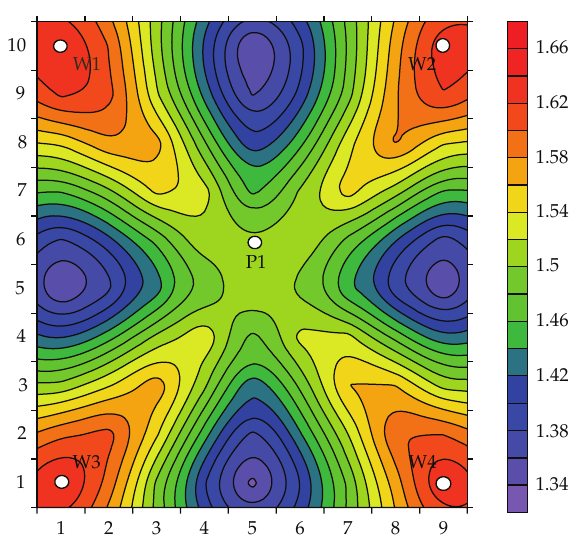
Figure 1: Permeability (cid:2) μ m 2 (cid:3) distribution.